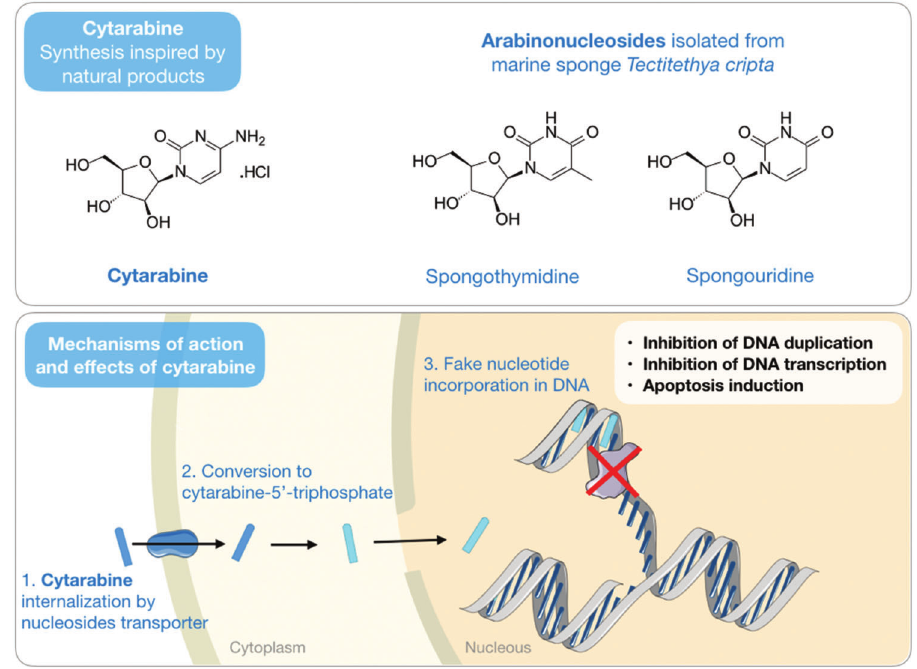
Figure 1 - Chemical structures of cytarabine and related natural products, spongothymidine and spongouridine, isolated from the marine sponge Tectitethya cripta (top). A schematic representation of the mechanism of action of cytarabine in cancer cells (bottom).